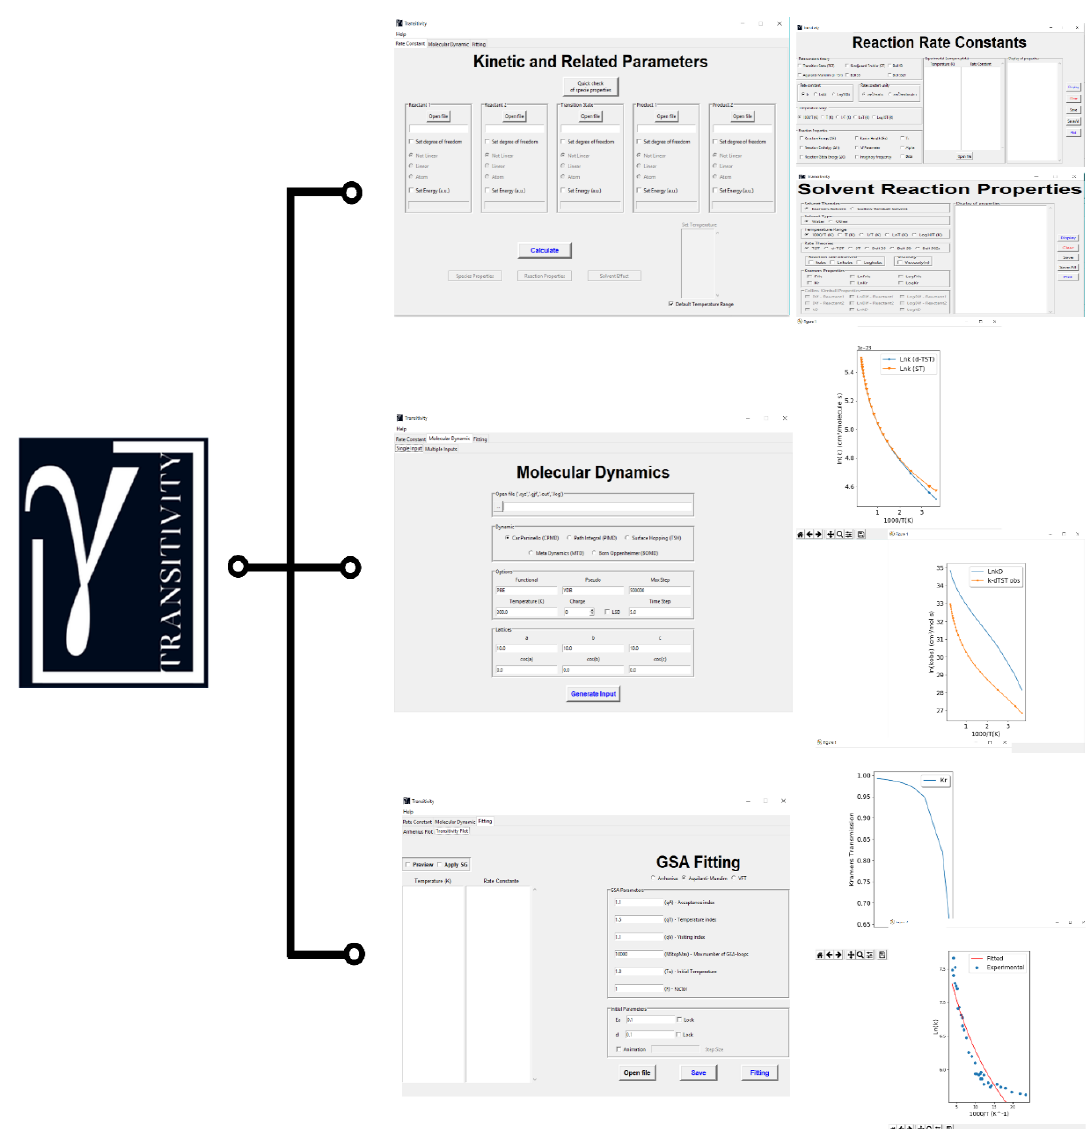
Figure 1. Logo and main windows of the Transitivity code.